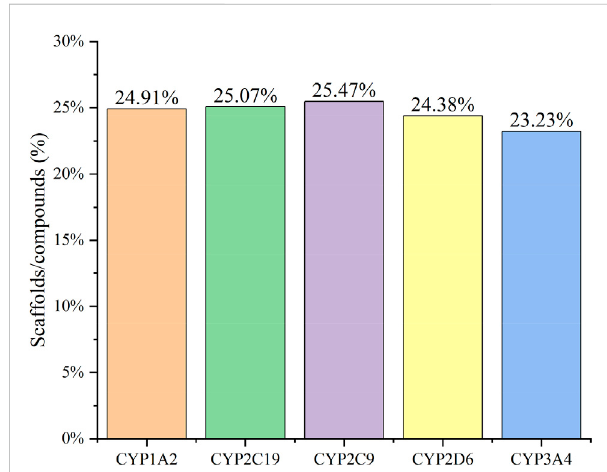
FIGURE 4 The Bemis Murcko scaffold analysis of CYP1A2 (orange),